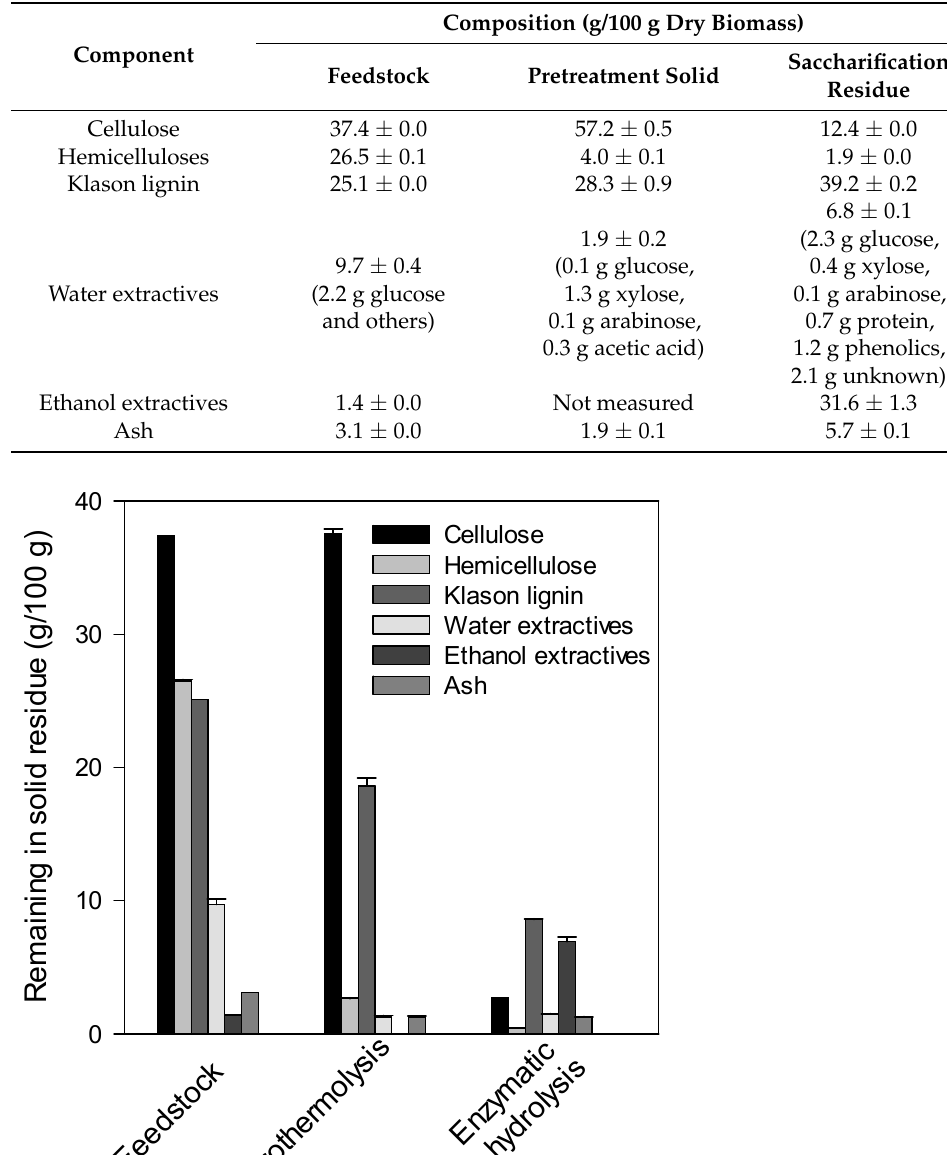
Table 1. Composition of Miscanthus feedstock, pretreatment solid, and saccharification residue.